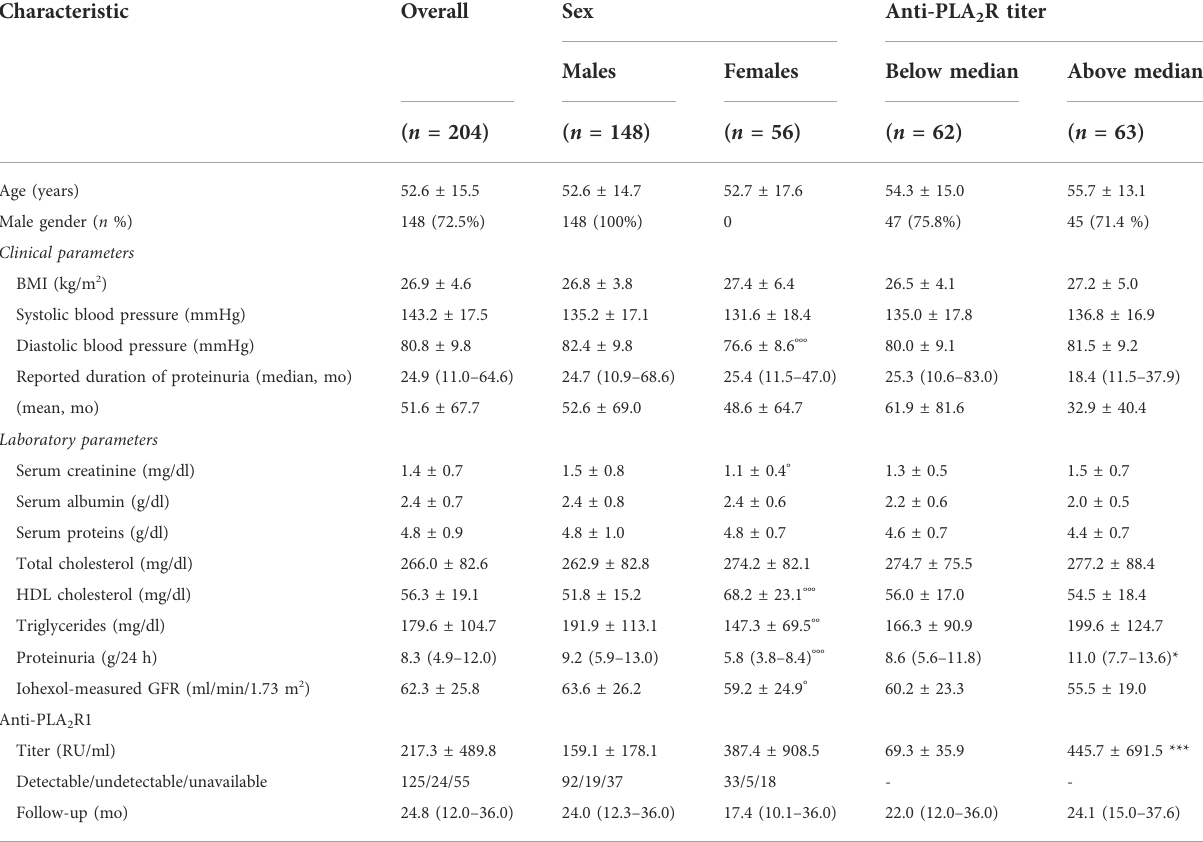
TABLE1Baselinecharacteristicsandfollow-updurationofpatientsinthestudygroupasawhole(overall)andconsideredseparatelyaccordingtosex and to anti-PLA 2 R below or above the median.